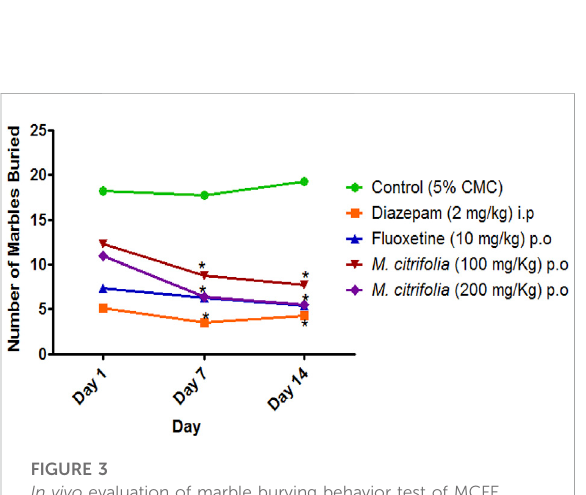
FIGURE 3 In vivo evaluation of marble burying behavior test of MCFE.